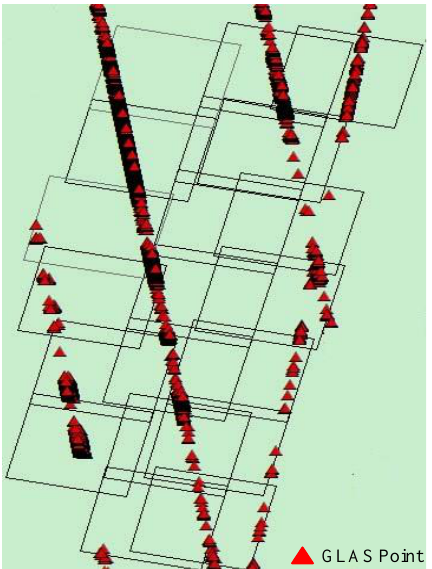
Figure 3. The ZY-3 and GLAS points location in Taihang Mountain experimental region